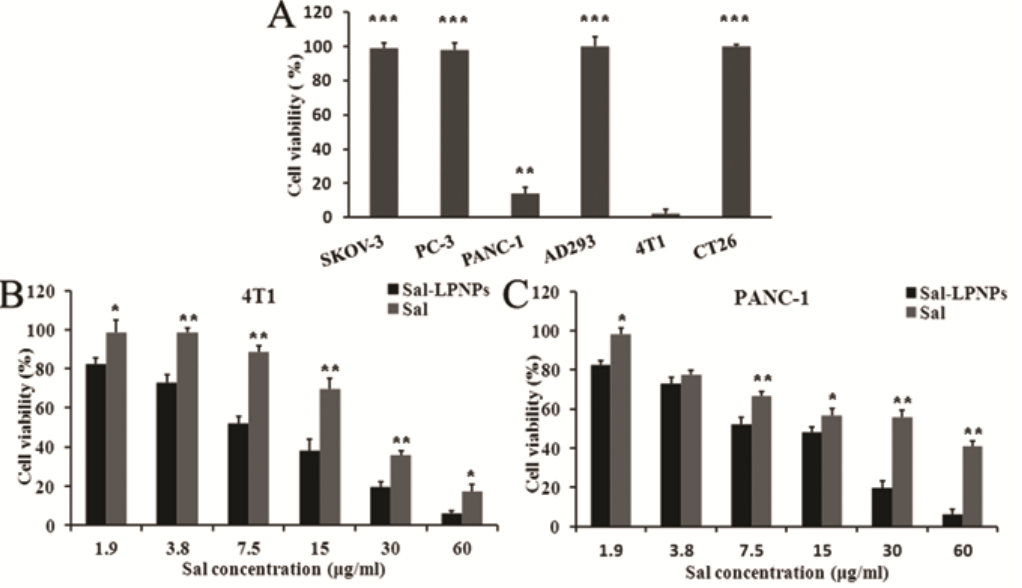
Figure 9. The cytotoxity of free Sal and Sal-LPNPs. ( A ) Three human originated cancer cell lines (SKOV-3, PC-3 and PANC-1), two mouse originated cancer cell lines (CT26 and 4T1) and one human normal cell line AD293 were treated with 100 μ g/mL Sal for 48 h, respectively. * indicated there was significant difference ( p < 0.05) compared to 4T1 cell line; ( B ) 4T1 cells were treated with Sal or Sal-LPNPs at different concentrations for 48 h; ( C ) PANC-1 cells were treated with Sal or Sal-LPNPs at different concentrations for 48 h. ** p < 0.01, *** p < 0.001.